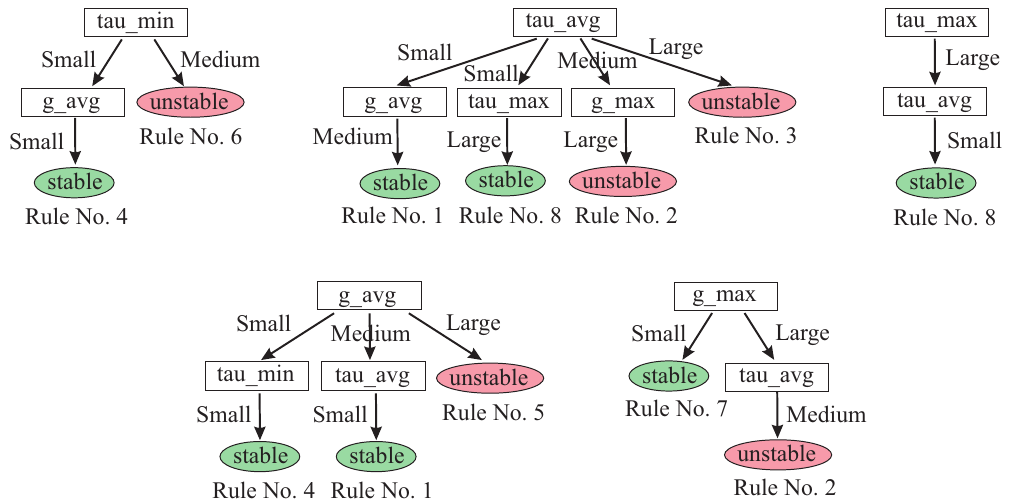
Figure 6. Transformation of fuzzy classification rules from Table 9 into decision-tree